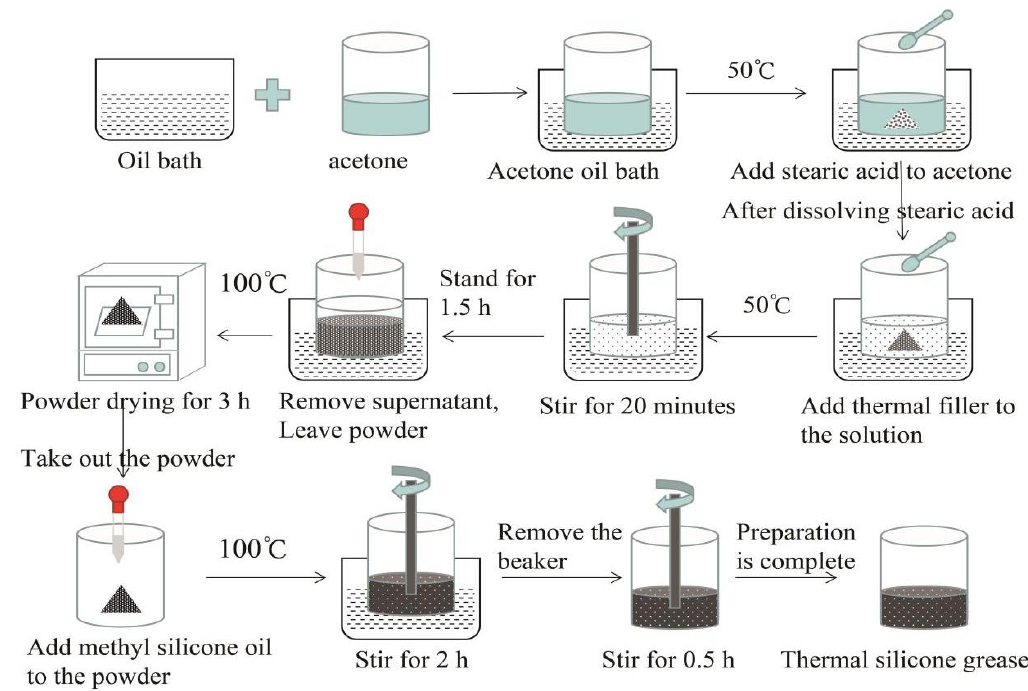
Figure 4. Flow chart of preparation of TSG.